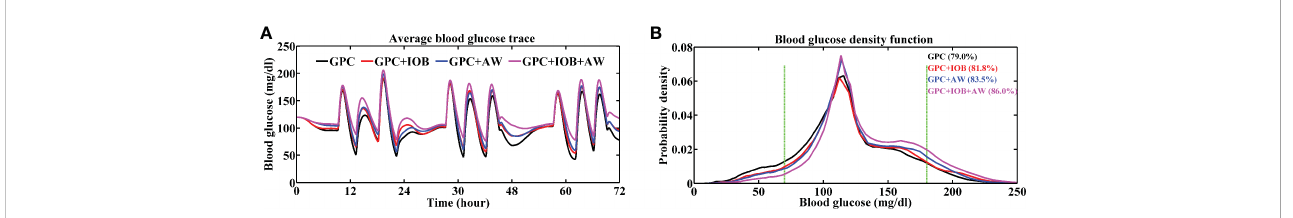
FIGURE 3 Average BG trace (A) and BG density (B) of 9 in-silico subjects. The TIR of the patient group with different controller is labeled in brackets. Green lines denote the euglycemic range. Black line represents the test with GPC controller, red line represents the test with GPC+IOB controller, blue line represents the test with GPC+AW controller and the pink line represents the test with GPC+IOB+AW